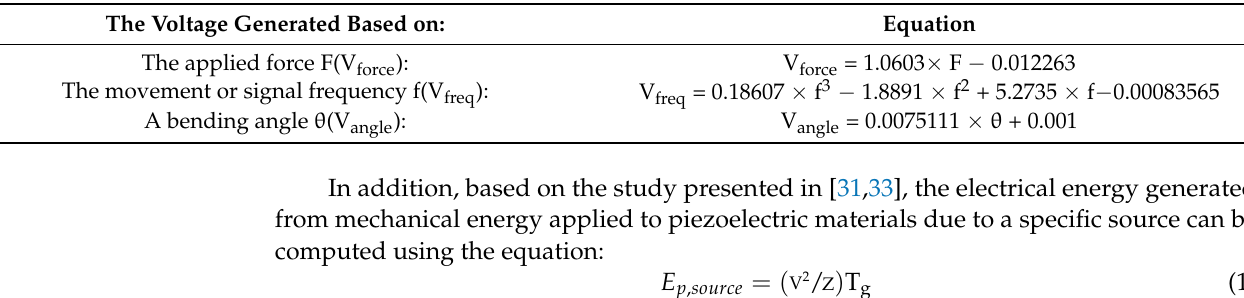
Table 1. The fitting equations for the different applied forces, frequencies, and bending